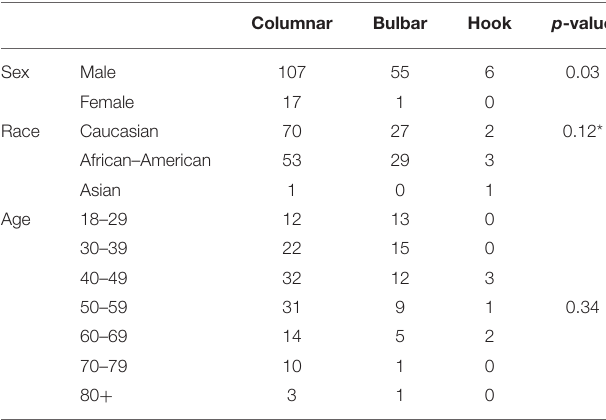
TABLE 3 | Anterior inferior iliac spine anatomic classification. Columnar Bulbar